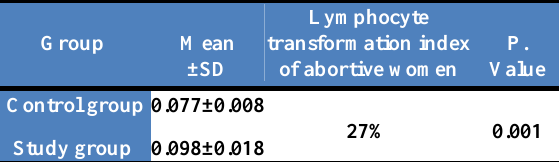
Table, 3: Lymphocyte transformation index for abortive